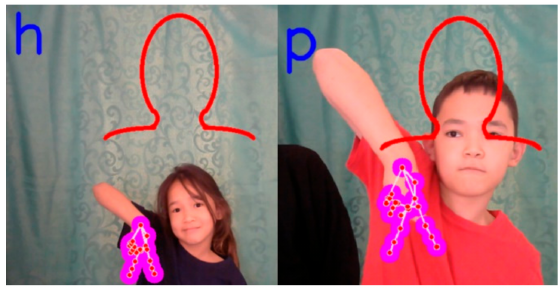
Figure 17. An example of incorrect system operation.